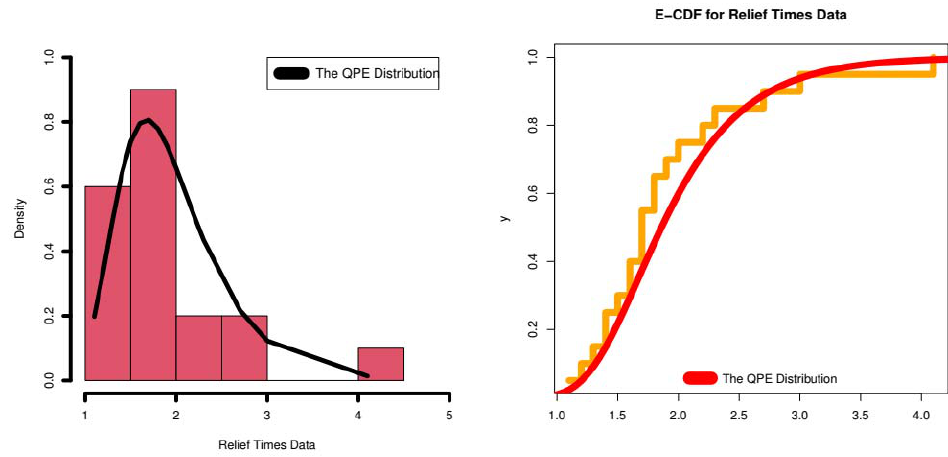
Figure 3. E-PDF ( left panel ) and E-CDF ( right panel ) for relief times data. Figure 3. E ‐ PDF ( left panel ) and E ‐ CDF ( right panel ) for relief times data. Figure 3 (E-PDF (the left graph) and E-CDF (the right graph)) and Figure 4 (KMS plot